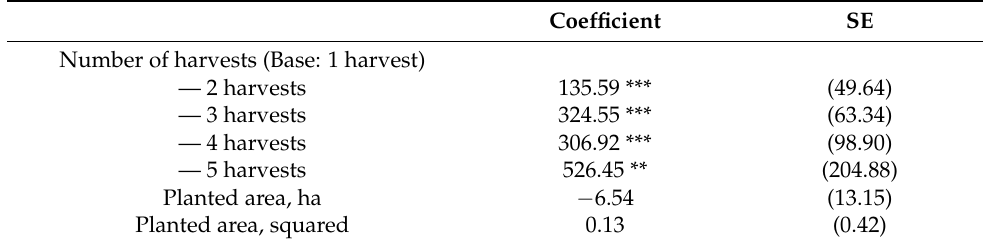
Table A2. Association between the frequency of harvests and mungbean yield in